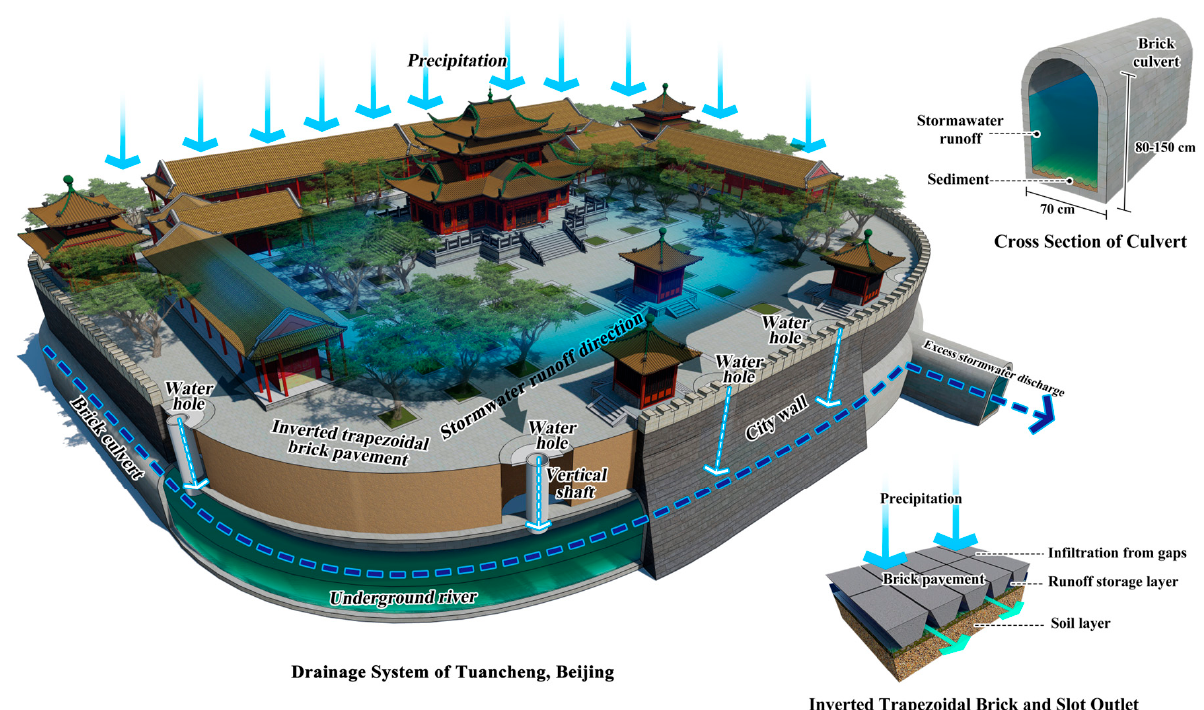
Figure 2. Typical ancient drainage system of Tuancheng, Beijing in northern region.